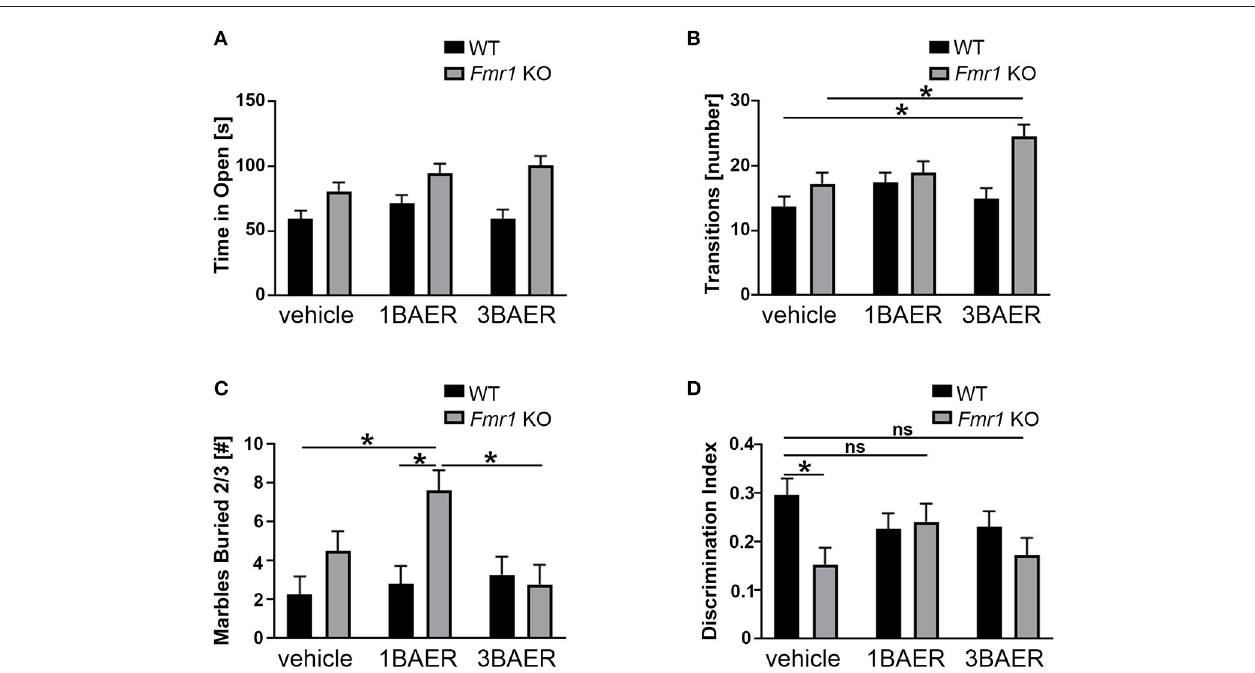
FIGURE 5 | BAER-101 may worsen anxiety-related and repetitive behaviors but improve memory in Fmr1 KO mice. (A,B) Fmr1 KO mice spent more time in the open (A) and made more transitions (B) than WT littermates in the elevated zero maze; BAER-101 does not affect time in the open but 3 mg/kg BAER-101 increases the number of transitions between open and closed compartments [ A , 2-way ANOVA, p (genotype) < 0.0001, p (treatment) = 0.13, p (interaction) = 0.32; B , 2-way ANOVA with FDR-corrected pairwise comparisons, p (genotype) = 0.0007, p (treatment) = 0.047, p (interaction) = 0.056, * p (wt/veh-ko/3BAER) = 0.0015, * p (ko/veh-ko/3BAER) = 0.019]. (A,B) WT vehicle: n = 23, WT 1BAER: n = 25, WT 3BAER: n = 23, Fmr1 KO vehicle: n = 19, Fmr1 KO 1BAER: n = 20, Fmr1 KO 3BAER: n = 20. (C) Increased marble burying behavior in Fmr1 KO mice is enhanced by 1 mg/kg BAER-101 [2-way ANOVA with FDR-corrected pairwise comparisons, p (genotype) = 0.008, p (treatment) = 0.066, p (interaction) = 0.03, * p (wt/veh-ko/1BAER) = 0.005, * p (wt/1BAER-ko/1BAER) = 0.008, * p (ko/1BAER-ko/3BAER) = 0.008). Number of marbles buried by two thirds or more after 10min is shown. (D) 1 mg/kg BAER-101 may improve impaired novel object recognition memory in Fmr1 KO mice [2-way ANOVA with FDR-corrected pairwise comparisons, p (genotype) = 0.028, p (treatment) = 0.62, p (interaction) = 0.073, * p (wt/veh-ko/veh) = 0.040, all other pairwise comparison not significant]. Shown is the discrimination index DI [(time with the novel object—-time with familiar object)/(time with the novel object + time with the familiar object)]. (C,D) WT vehicle: n = 23, WT 1BAER: n = 25, WT 3BAER: n = 24, Fmr1 KO vehicle: n = 21, Fmr1 KO 1BAER: n = 20, Fmr1 KO 3BAER: n = 20. *indicates a significant difference, ns indicates not